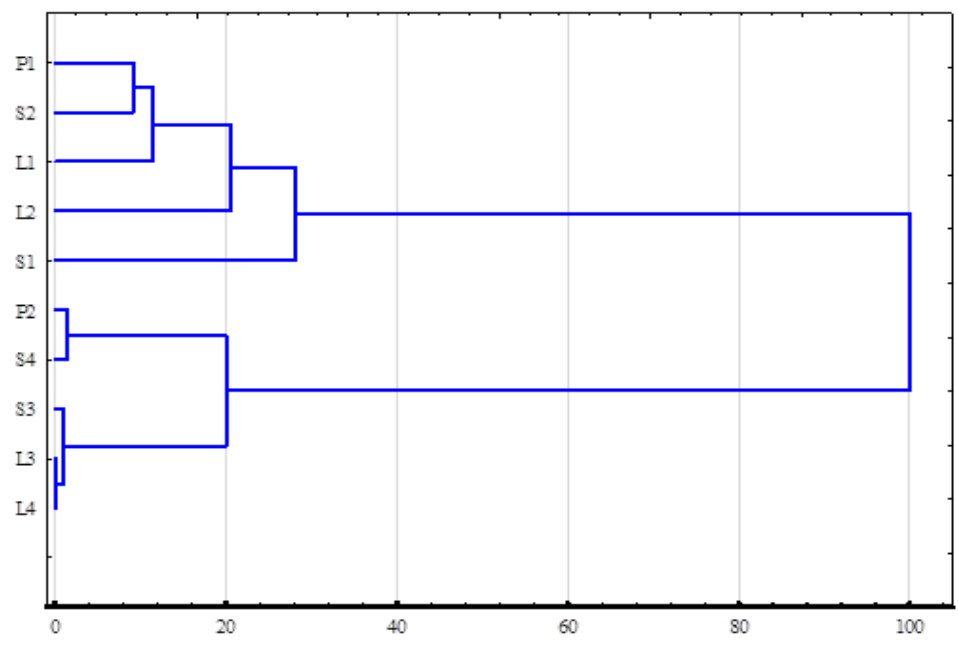
Figure 1. Dendrogram of cluster analysis of the similarity of the microbiological profile of analyzed samples; P — Police Sea port waters: P1, autumn and P2, winter; S — short-range vessel: S1 – S2, autumn and S3 – S4. winter; L — long-range vessel: L1 – L2, autumn and L3 – L4, winter.